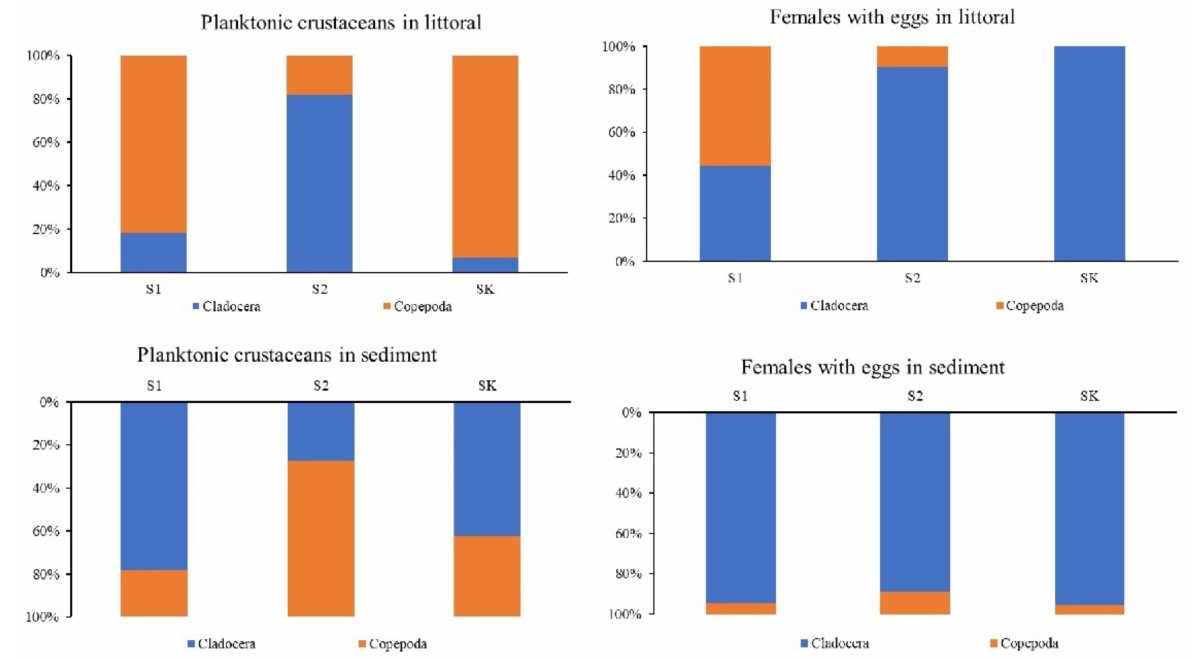
Figure 4. Relative abundance of planktonic crustaceans, Cladocera and Copepoda, and females with eggs in littoral water zone and sediment in the three